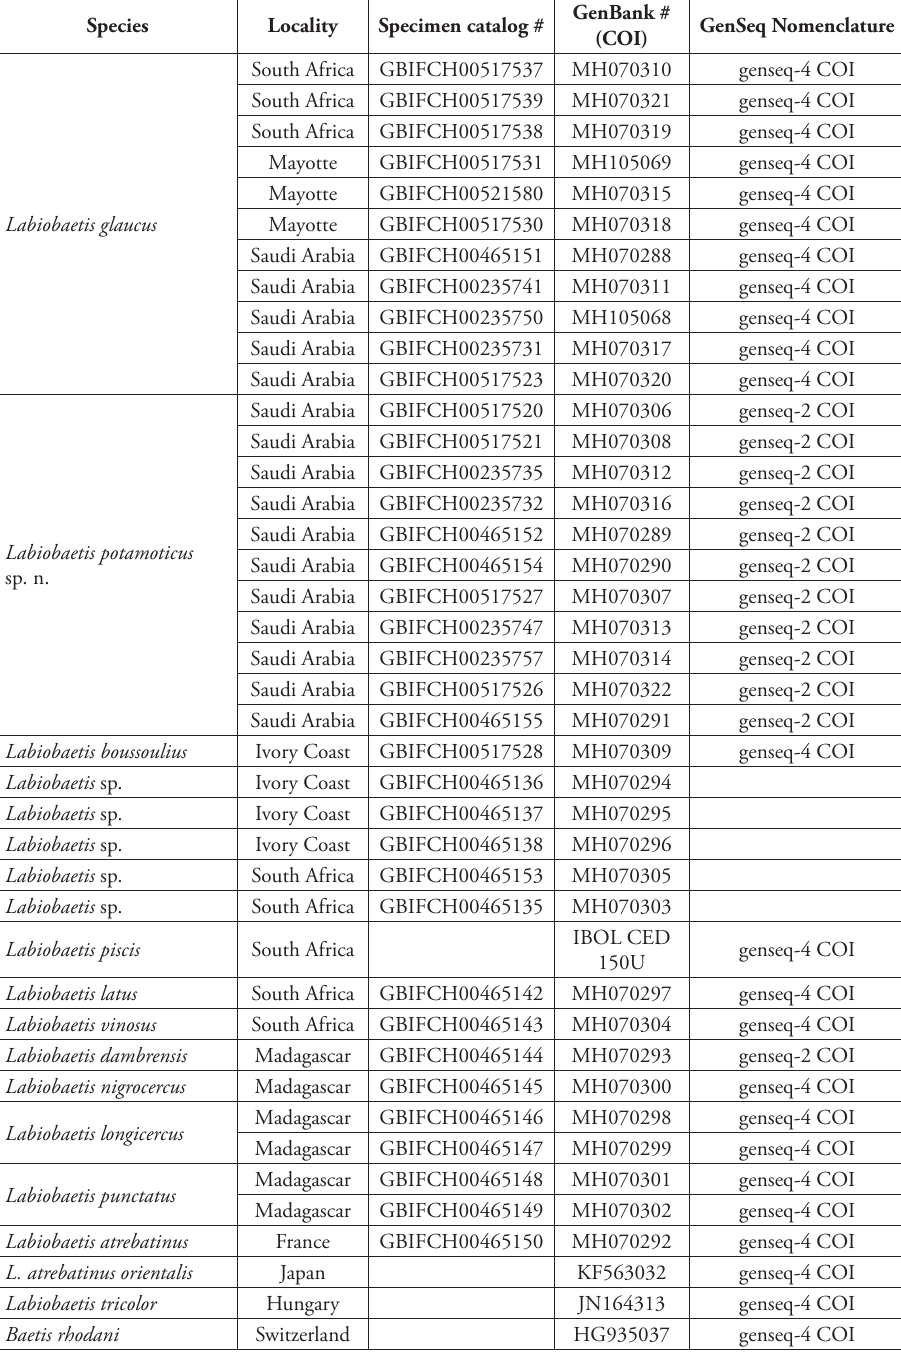
Table 1. Specimens used for the phylogenetic analysis of the mitochondrial gene